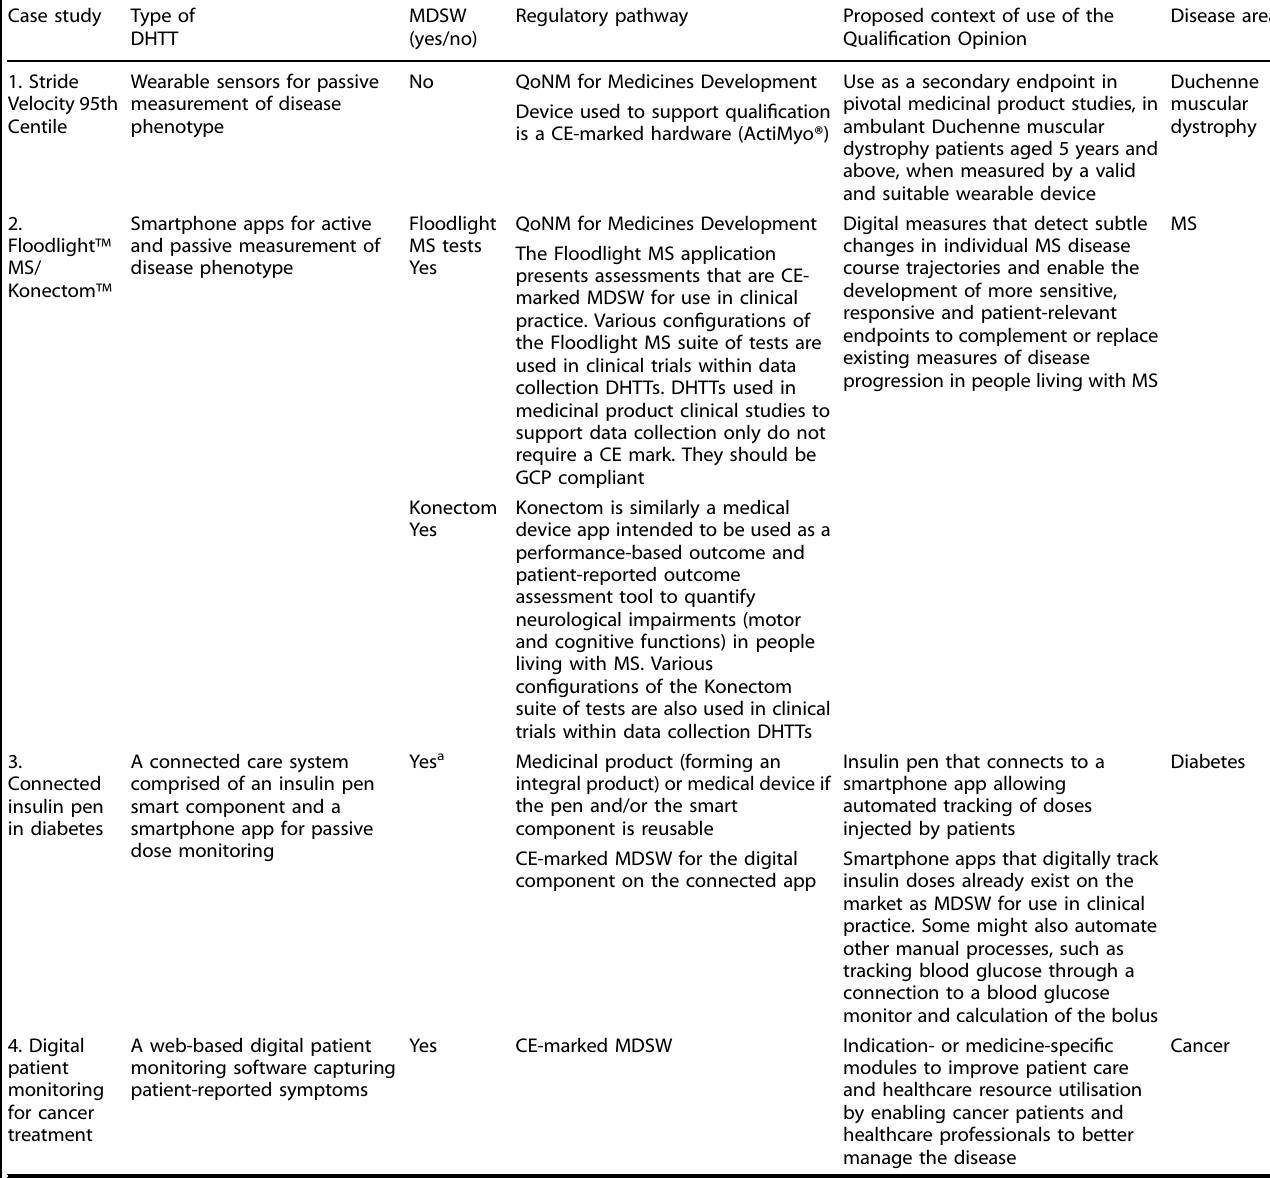
Table 1. Summary of case